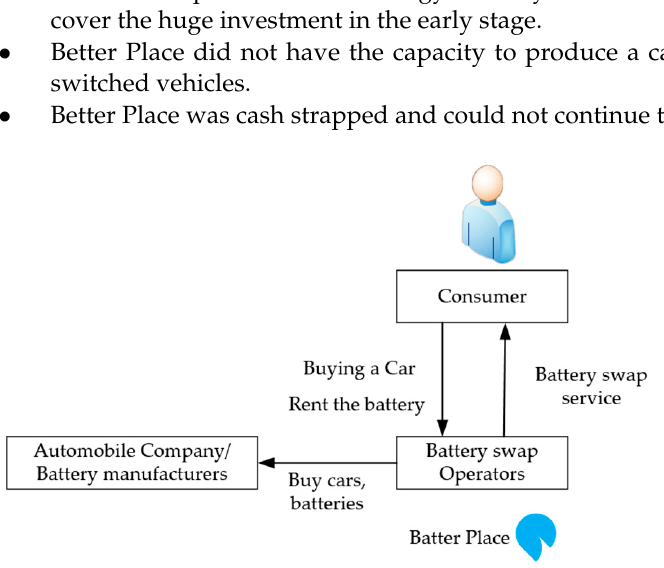
Figure 5. Battery swapping business model of Better Place.